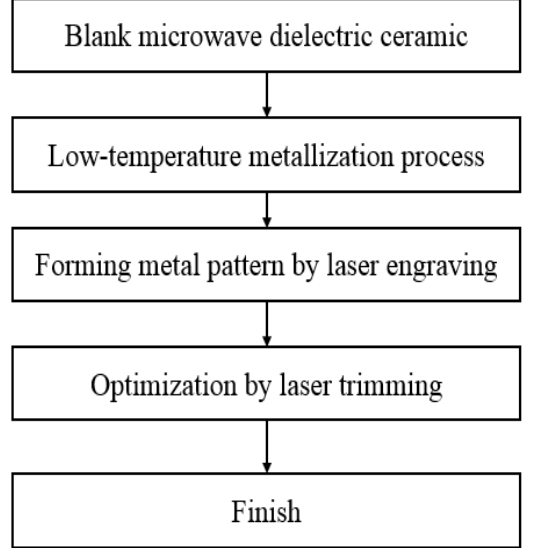
Figure 3. The complete low-temperature metallization and laser trimming processes.